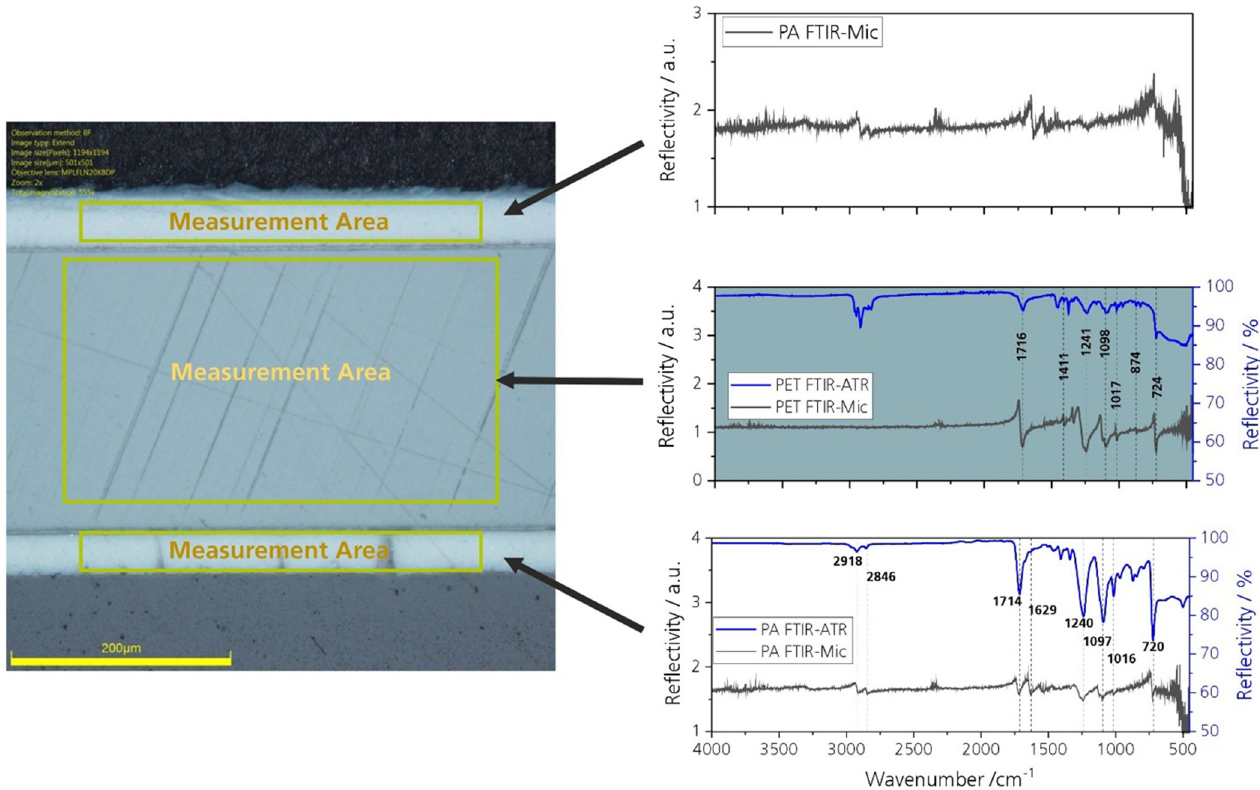
Fig. 5. Left: Microscopy image of the multilayer PA/PET/PA backsheet cross-section in a PV module. Right: Comparison of FTIR microscopy spectra (black) of cross-section samples and ATR-FTIR spectroscopy spectra (blue) of separated backsheet surface layers.